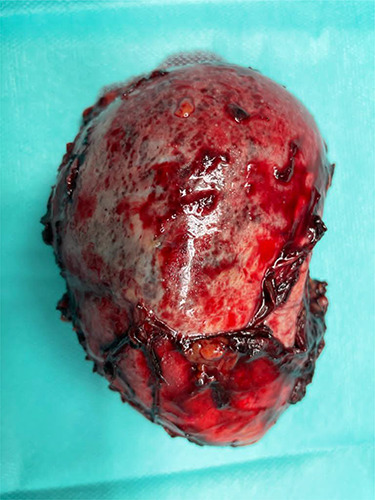
Resected specimen.